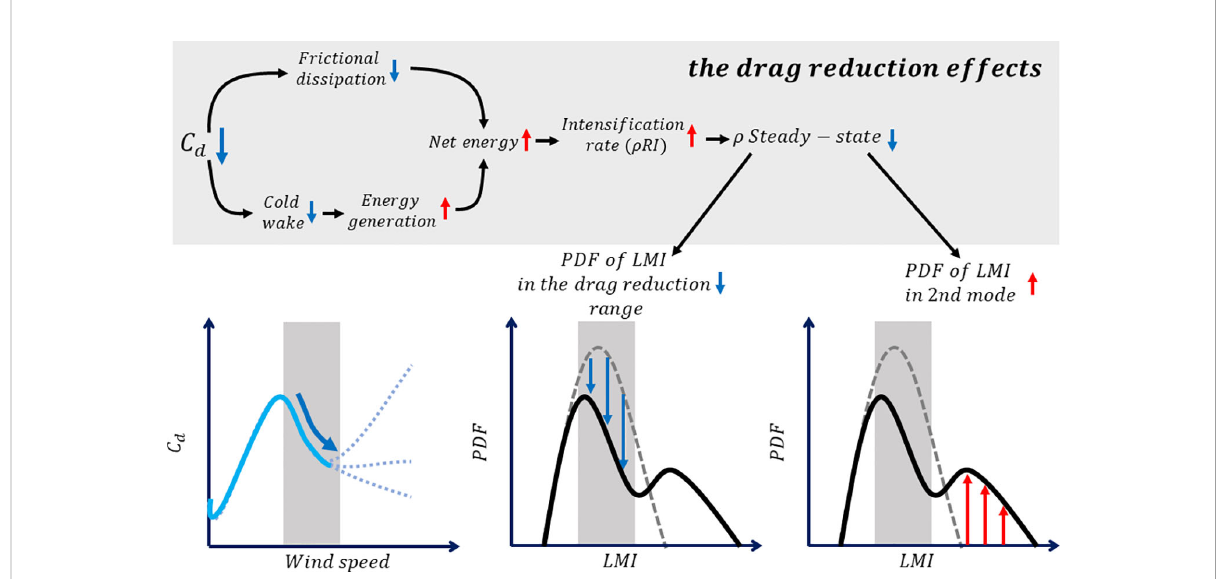
FIGURE 5 Process fl ow diagram of the drag reduction effects on the distribution of lifetime maximum